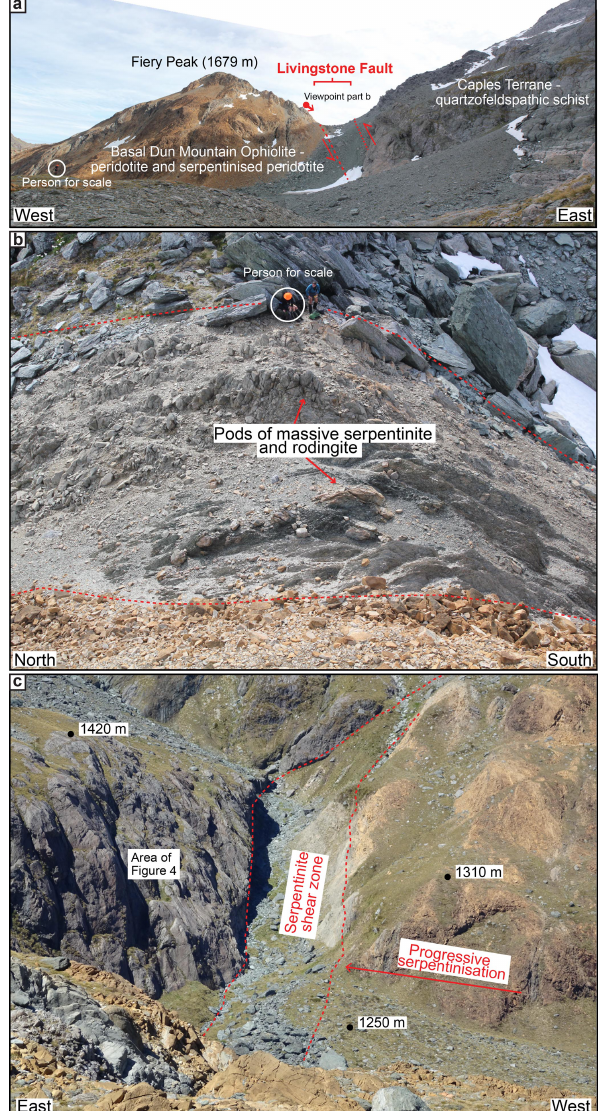
Figure 3. Typical field exposures of the Livingstone Fault where it crosses high passes. Red dashed lines approximate the bound- aries of the serpentinite shear zone. (a) Panorama of Fiery Col viewed from the south. Person for scale circled in white. Here, the shear zone separates massive serpentinite and serpentinised peri- dotite from schists of the Caples–Aspiring Terrane. (b) Fiery Col viewed from below Fiery Peak (location shown in panel a ). Elon- gate pods of massive serpentinite are surrounded by scaly serpen- tinite. The boundaries between the serpentinite shear zone and the wall rocks are well defined. (c) Cow Saddle viewed from the north. The DMOB wall rocks are progressively serpentinised towards the western boundary of the shear zone. The area shown in Fig. 4 is also